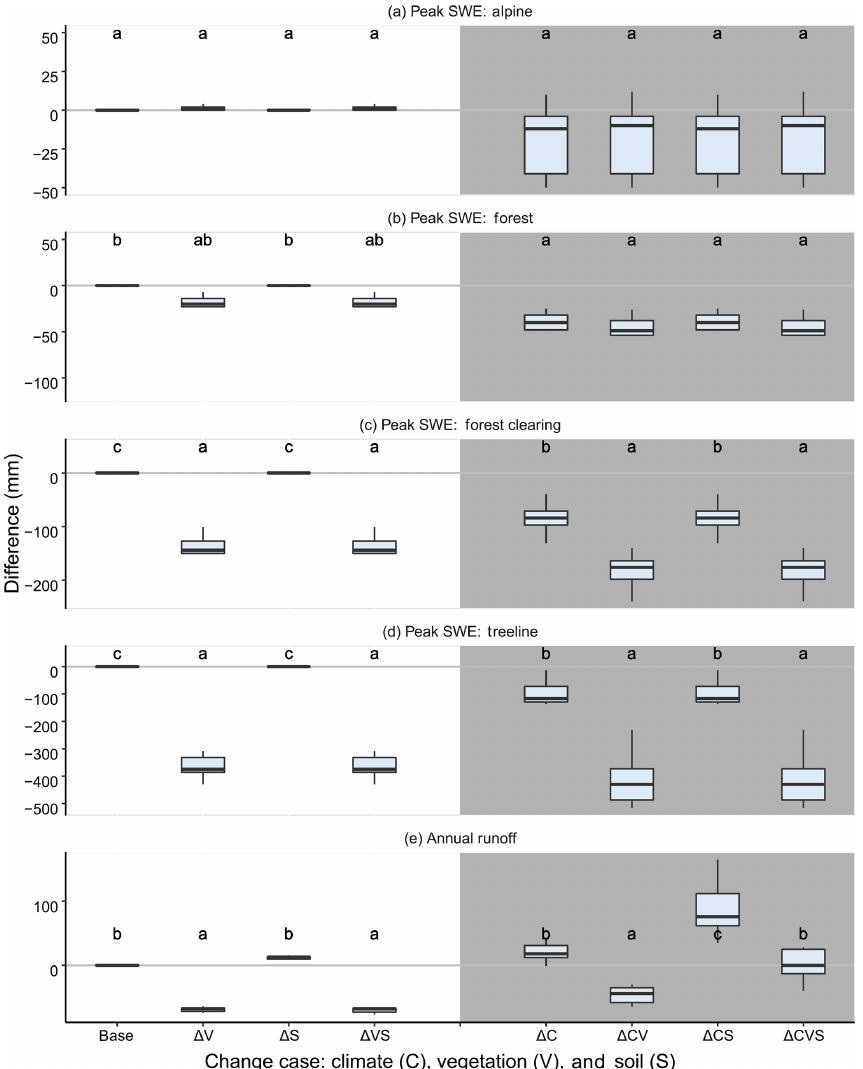
Figure 4. Differences in peak snow water equivalent (SWE) and annual runoff volume under seven combinations of changes in climate, vegetation, and soil in the Marmot Creek Research Basin relative to present climate, present vegetation, and present soil with no change (base). Lower case letters from the Tukey HSD test indicate groups that are significantly different from each other. The unshaded cases on the left-hand side of the plot demonstrate changes under modeled present climate, and the shaded cases on the right-hand side of the plot demonstrate vegetation and soil changes under modeled future